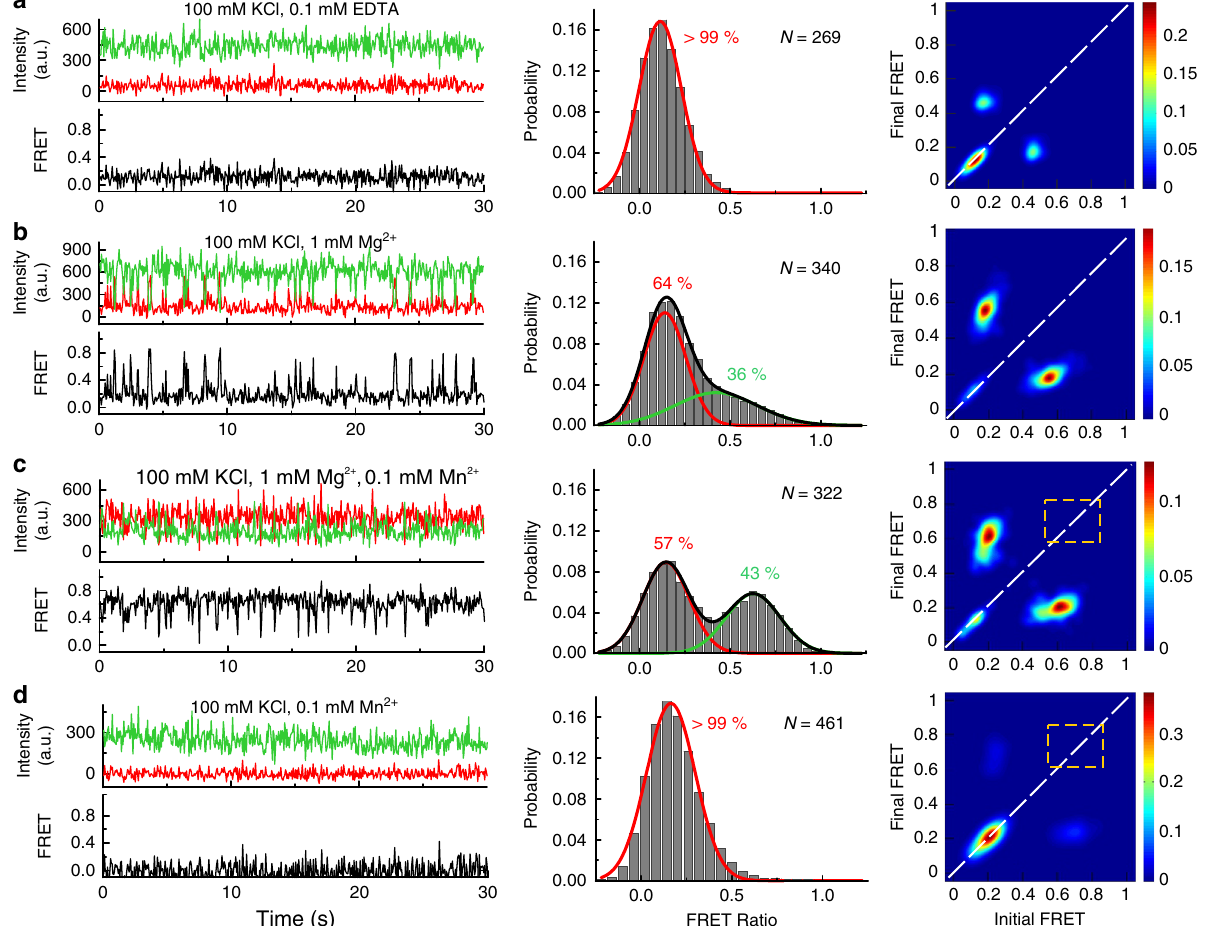
Fig. 6 Mutation of the Mn 2 + sensing A48 leads to loss of the SD conformation. Representative smFRET traces, FRET histograms and TODPs for the A48U mutant riboswitch under: a no divalents ( + 0.1 mM EDTA), b 1 mM Mg 2 + alone, c 1 mM Mg 2 + and 0.1 mM Mn 2 + , and d 0.1 mM Mn 2 + alone. The dashed yellow box highlights the absence of SD conformations for the A48U riboswitch in the presence of Mn 2 + , in contrast to the WT riboswitch